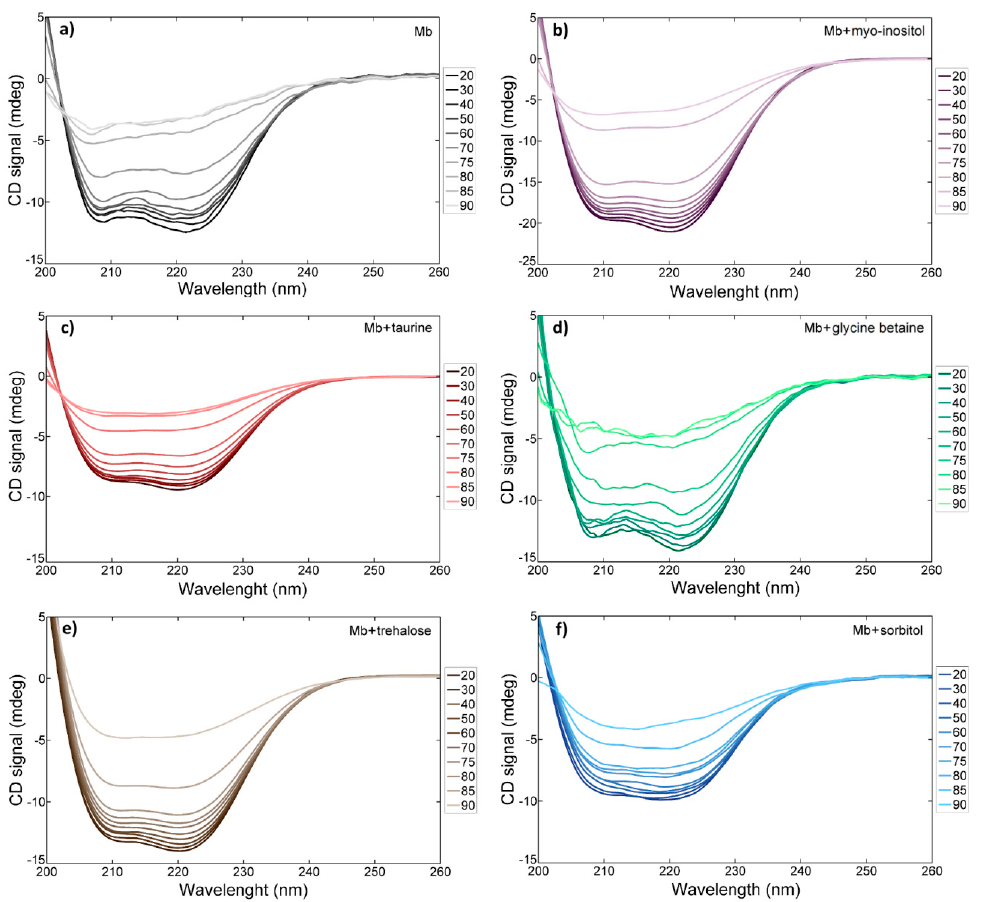
Figure 6. Temperature-dependent CD spectra of metmyoglobin backbone in ( a ) 7.0 pH phosphate buffer, ( b ) 0.9 M myo-inositol, ( c ) 0.9 M taurine, ( d ) 2.0 M glycine betaine, ( e ) 1.5 M trehalose and ( f ) 2.0 M sorbitol.